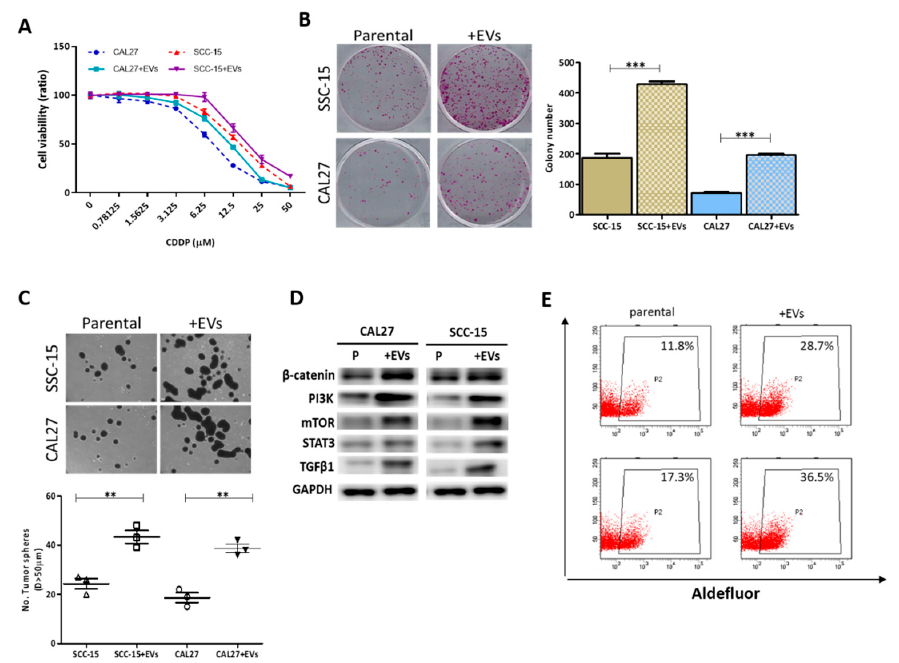
Figure 1. Extracellular vesicles (EVs) from cancer stem cells (CSCs) promoted malignant properties of oral squamous cell carcinoma (OSCC) cells. ( A ) A cell viability assay indicated that CSC_EV-cocultured CAL27 and SCC-15 cells showed markedly increased resistance against cisplatin (CDDP) compared to parental cells without CSC_EVs. ( B ) Increased colony-forming ability of both CAL27 and SCC-15 cells cocultured with CSC_EVs. ( C ) Increased migratory capacity of CAL27 and SCC-15 cells cocultured with CSC_EVs. ( D ) Western blot analysis showing that CSC_EVs promoted the stemness marker, β -catenin, and the oncogenic markers, phosphatidylinositol-3 kinase (PI3K), signal transducer and activator of transcription 3 (STAT3), mammalian target of rapamycin (mTOR), and transforming growth factor (TGF)- β 1in parental CAL27 and SCC-15 cells. ( E ) Flow cytometric analysis showing that CSC_EVs’ coculture significantly increased aldehyde dehydrogenase 1 (ALDH1) activity within both CAL27 and SCC-15 cells. * p < 0.05; ** p < 0.01; *** p < 0.001.